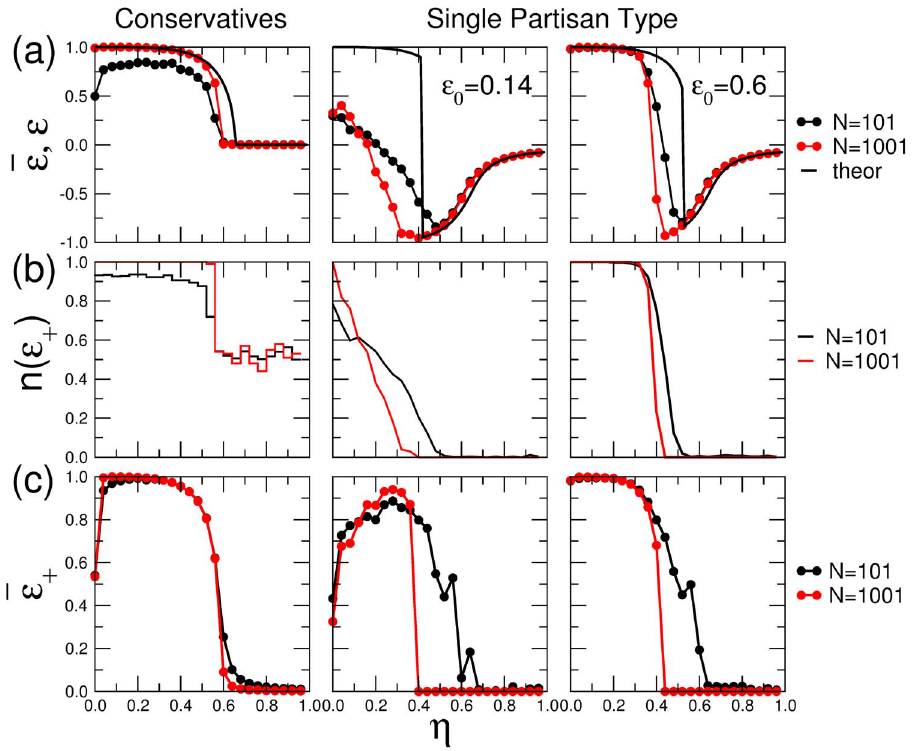
Figure 3. Comparison between model simulations for finite system sizes and the mean-field results. We consider populations of naive agents with 10 % of conservatives or negative partisan agents with bias strength s ~ 2 . We build a network following the model proposed by Watts and Strogatz [30] using the same parameters as in [10]– p ~ 0 : 15 and k ~ 6 . Once the system has reached a steady-state we obtain: (a) E , the average efficiency, (b) E z , the average efficiency for the realizations with positive efficiency, and (c) n ( E z ) the fraction of realizations in which is positive. We show results for populations of N ~ 101 (black) and 1001 (red) agents and 500 and 100 realizations, respectively. In the top row, solid black lines indicate the solution to the mean-field model E M F . In the case of negative partisans, we show results for two initial conditions E 0 ~ 0 : 14 and E 0 ~ 0 : 6 . Note how in the case of conservative agents there is a good agreement between simulations and the mean-field expectation. There is a transition from a regime in which almost all realizations have E ~ E z & E MF to a regime for g § g (cid:3) , in which the population ends half of the time with 0 v E % 1 . In the case with partisan agents, we show how the initial condition affects the behavior of the system as predicted. Note how there is a transition between a region in which some realizations have E w 0 , to a partisan regime in which no realizations have E w 0 and the efficiency is very similar to that of the mean-field approximation.